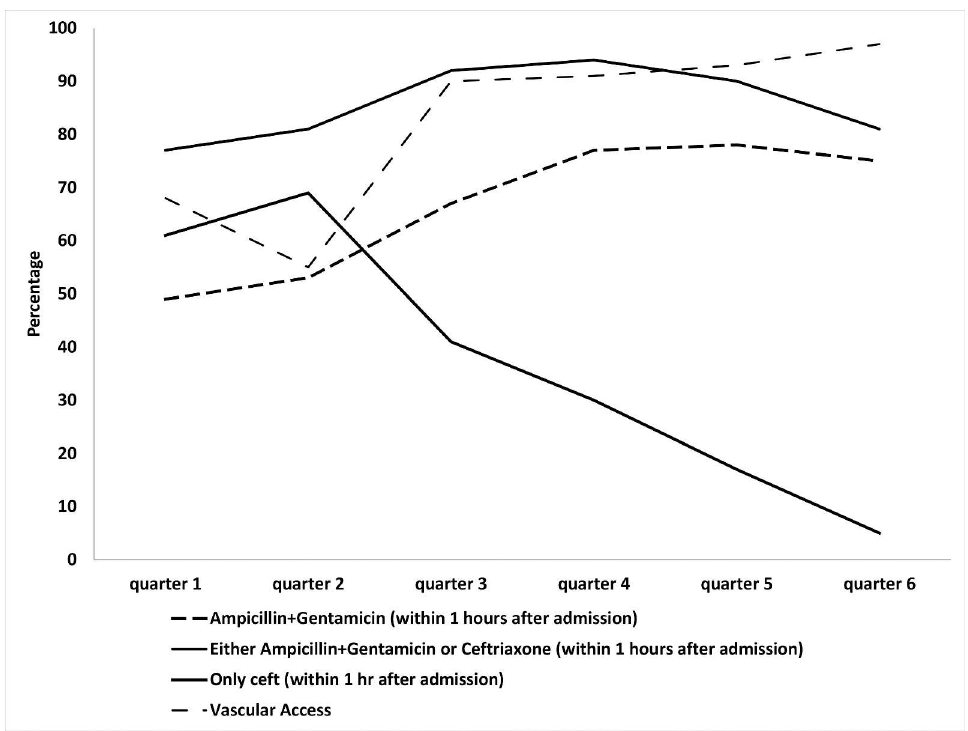
Fig 2. Quarter wise trend in the vascularaccessand use of first dose of parenteral antibiotics among syndromic sepsis patients in the inpatient department (August 2013-March